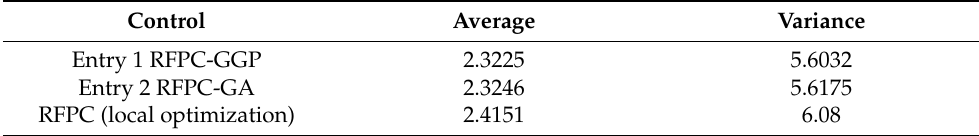
Table 1. Average and variance of the control sequence.